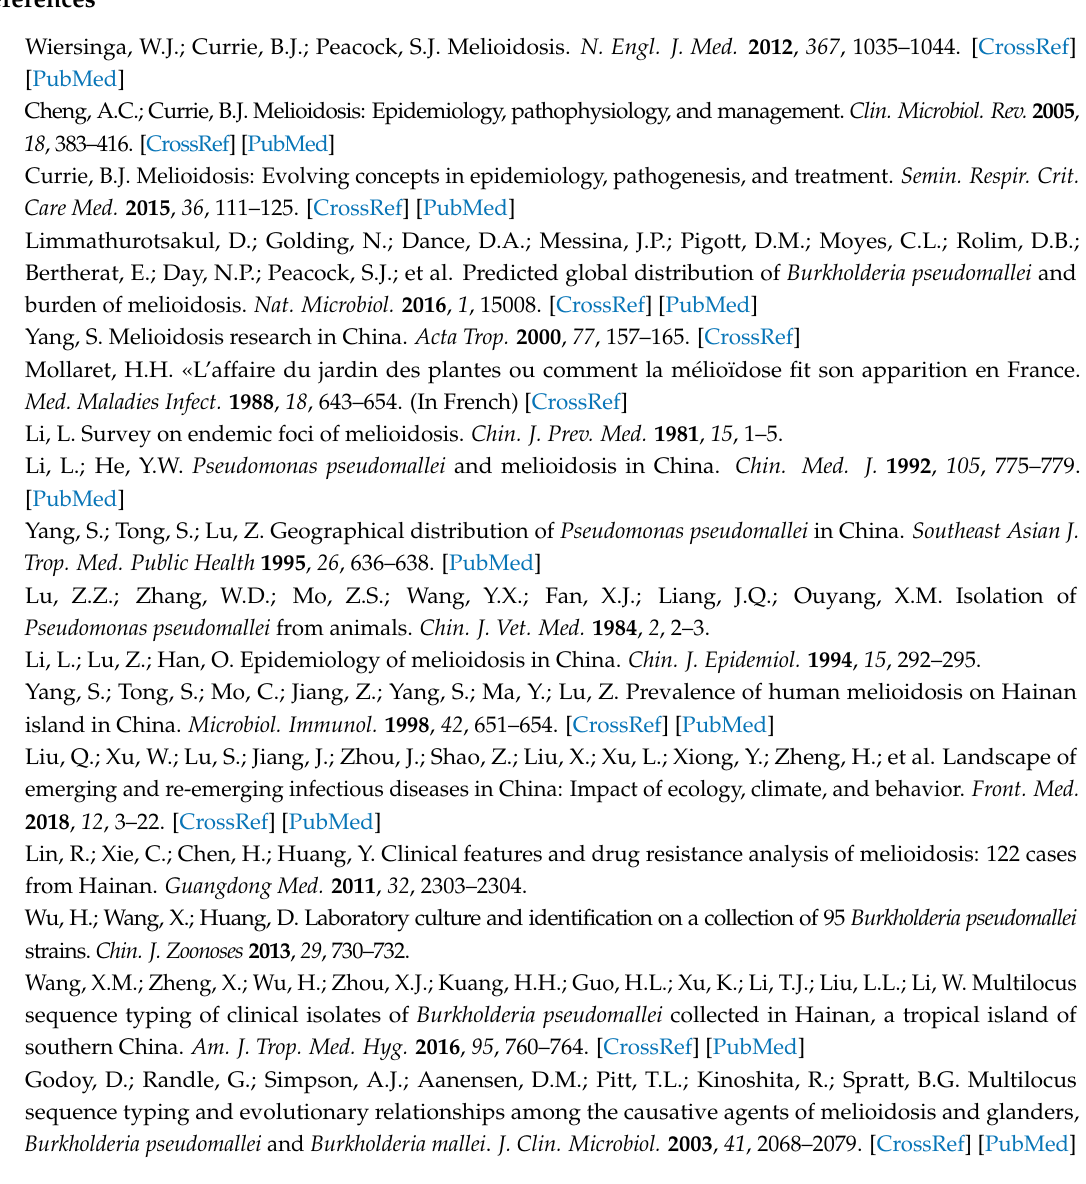
Table S1: Summary of the number of human melioidosis cases from endemic and non-endemic provinces of mainland China identified from different